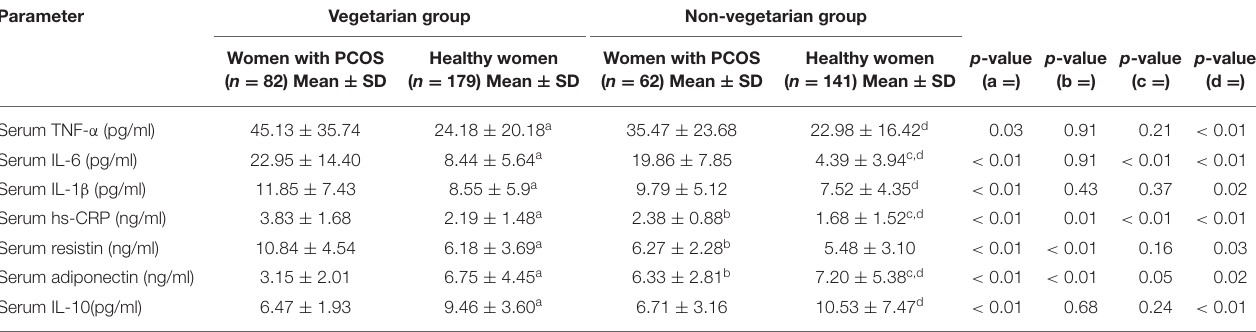
TABLE 3 | Showing comparison of serum biomarkers of inflammation among women with PCOS and healthy controls from Delhi and Srinagar.